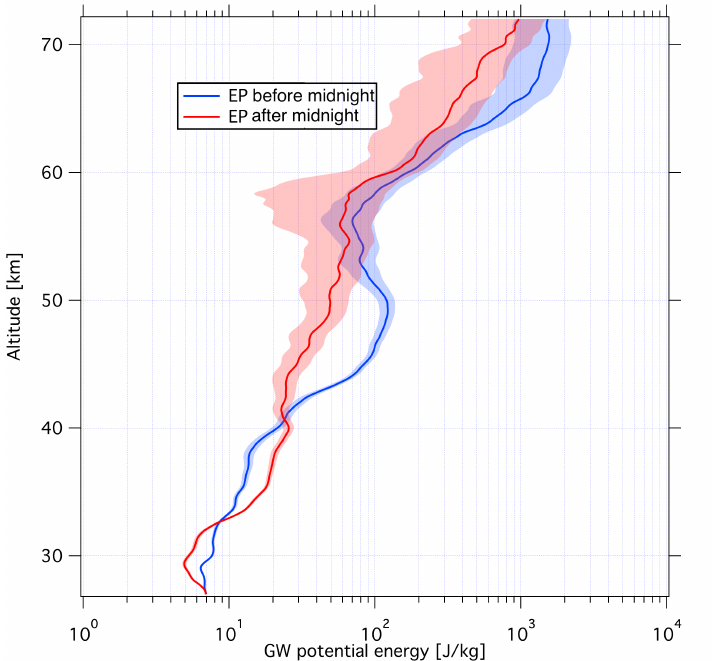
Figure 11. Evolution of potential energy with altitude before midnight (blue curve) and after (red curve). The shaded areas are the associated errors. Adapted from